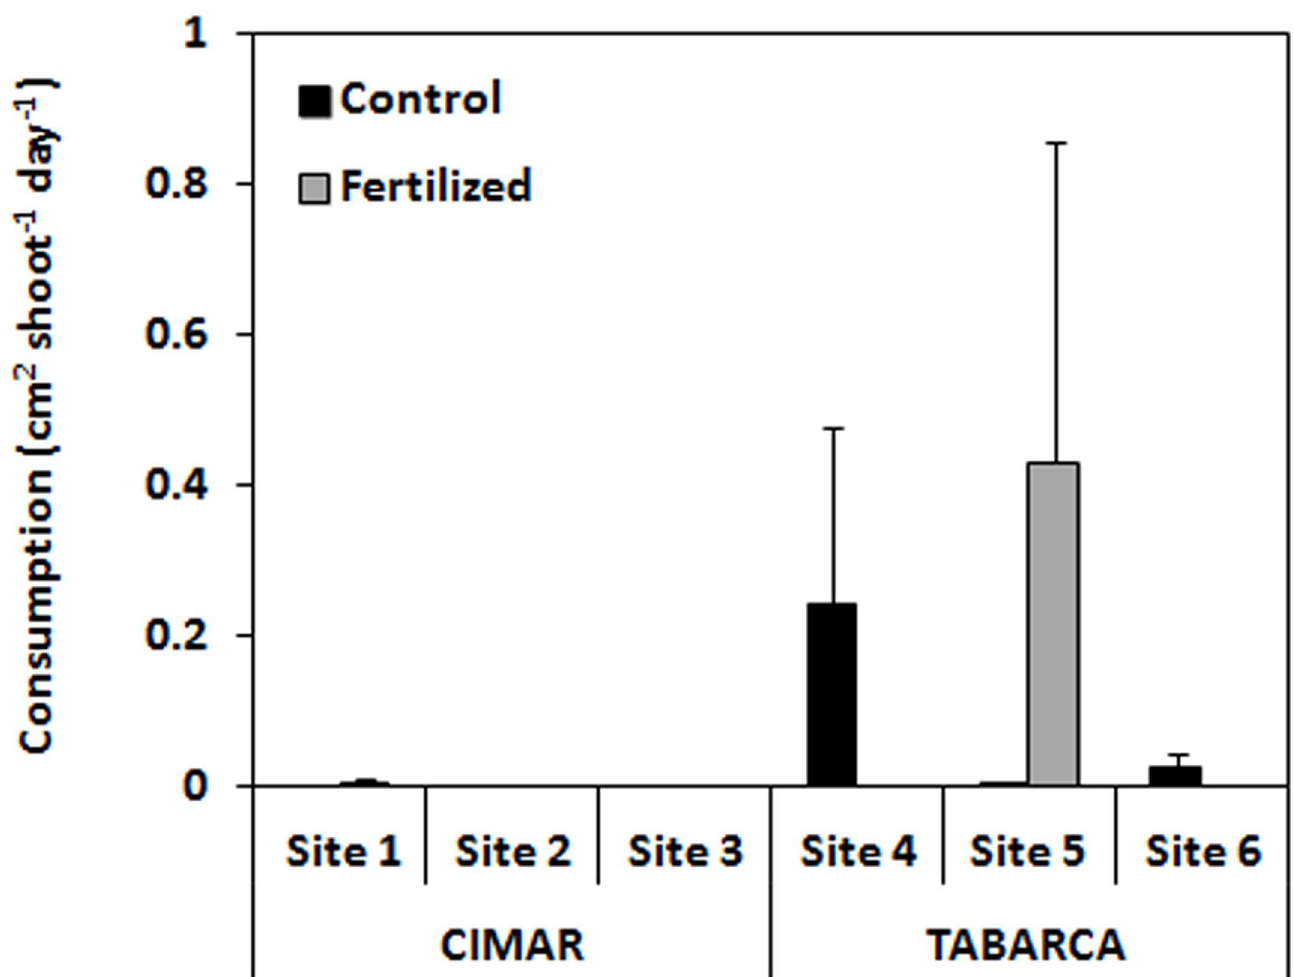
Fig 3. Consumption by S . salpa recorded at CIMAR and Tabarca in the different sites for control vs. fertilized treatments(cm 2 (cid:1) shoot -1 (cid:1) d -1 ). Mean ± SE.